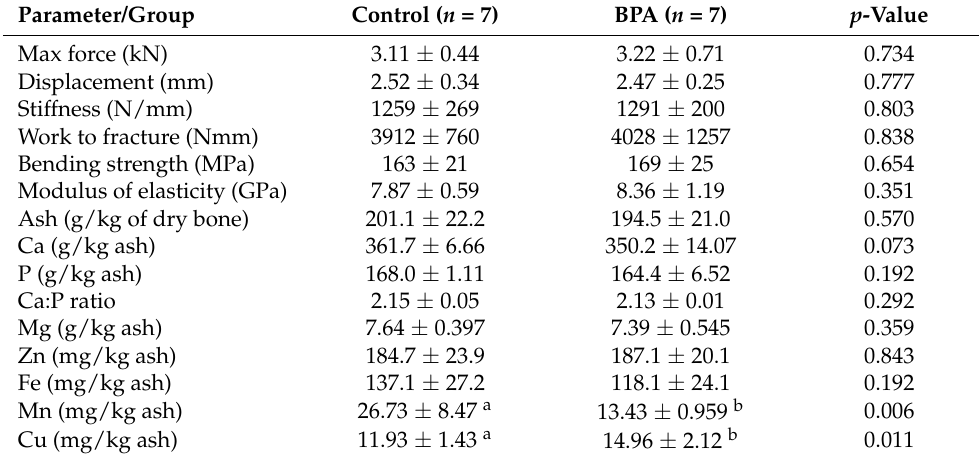
Table 4. Biomechanical parameters and mineral content of the left femur of rams in the BPA and control groups at the end of the study. The BPA group received 25 µ g BPA/kg bw/day for 64 days. Values are given as the mean ±